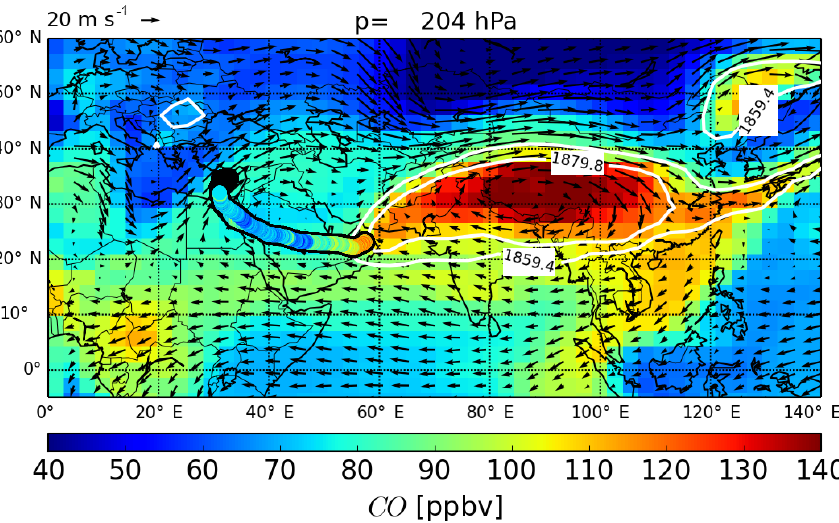
Figure 8. EMAC modelled CO and wind field; daily mean at 204hPa, and in situ CO (above 300hPa) along the flight track for flight 19 (13 August 2015). White contours represent the CH 4 threshold and background values according to Sect.